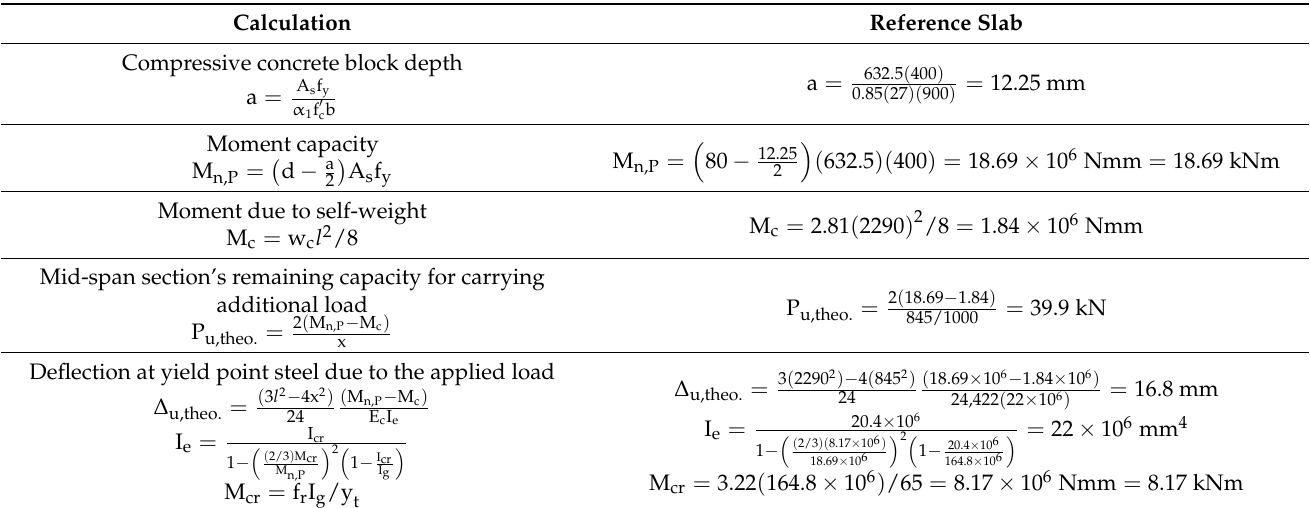
Table 3. Analysis of the reference RC